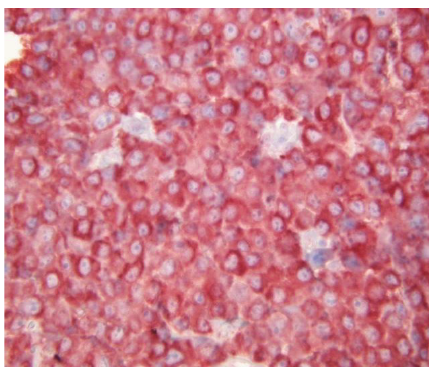
Figure 7: Biopsy of mass in the pancreatic head, kappa monotypic plasma cell